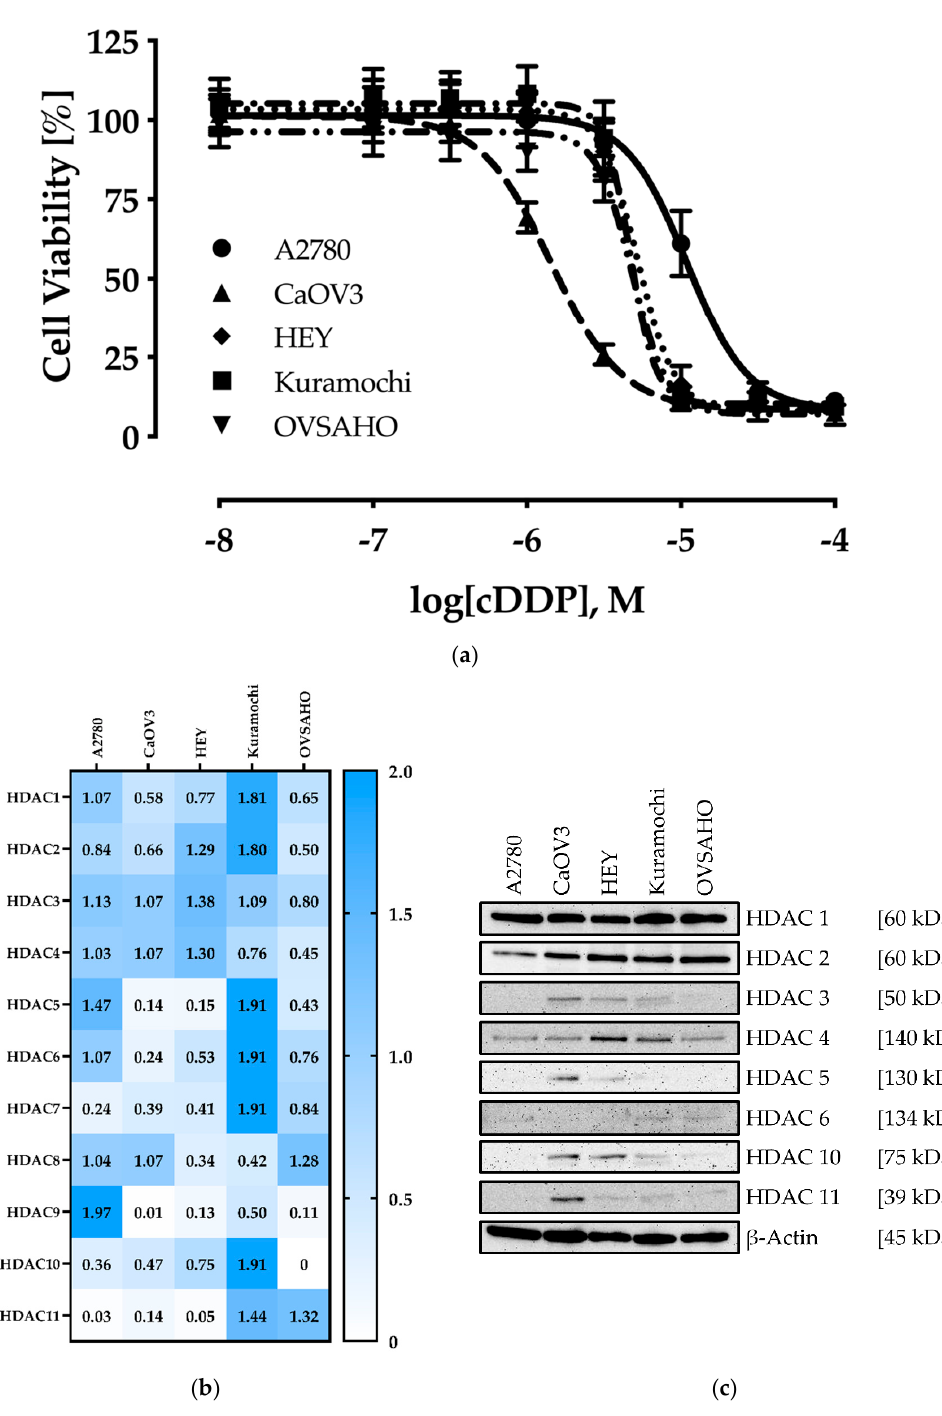
Figure 1. Characterization of the ovarian cancer cell lines. ( a ) Cell viability was measured by MTT assay after 72 h incubation with different concentrations of cisplatin. Data shown are mean ± SD of at least three independent experiments each carried out in triplicates, calculated as percentage of control. The cell line specific IC 50 values are shown in Table 1. ( b ) Gene expression profile for HDAC enzymes was obtained by RT-PCR. Data shown are normalized to endogenous control gene expression of HPRT1 (hypoxanthine-guanine phosphoribosyltransferase), TBP (TATA binding protein), and GUSB (beta-glucuronidase). ( c ) Representative immunoblot analysis of HDAC enzymes. One representative immunoblot with a protein molecular weight marker is shown in Figure S3.